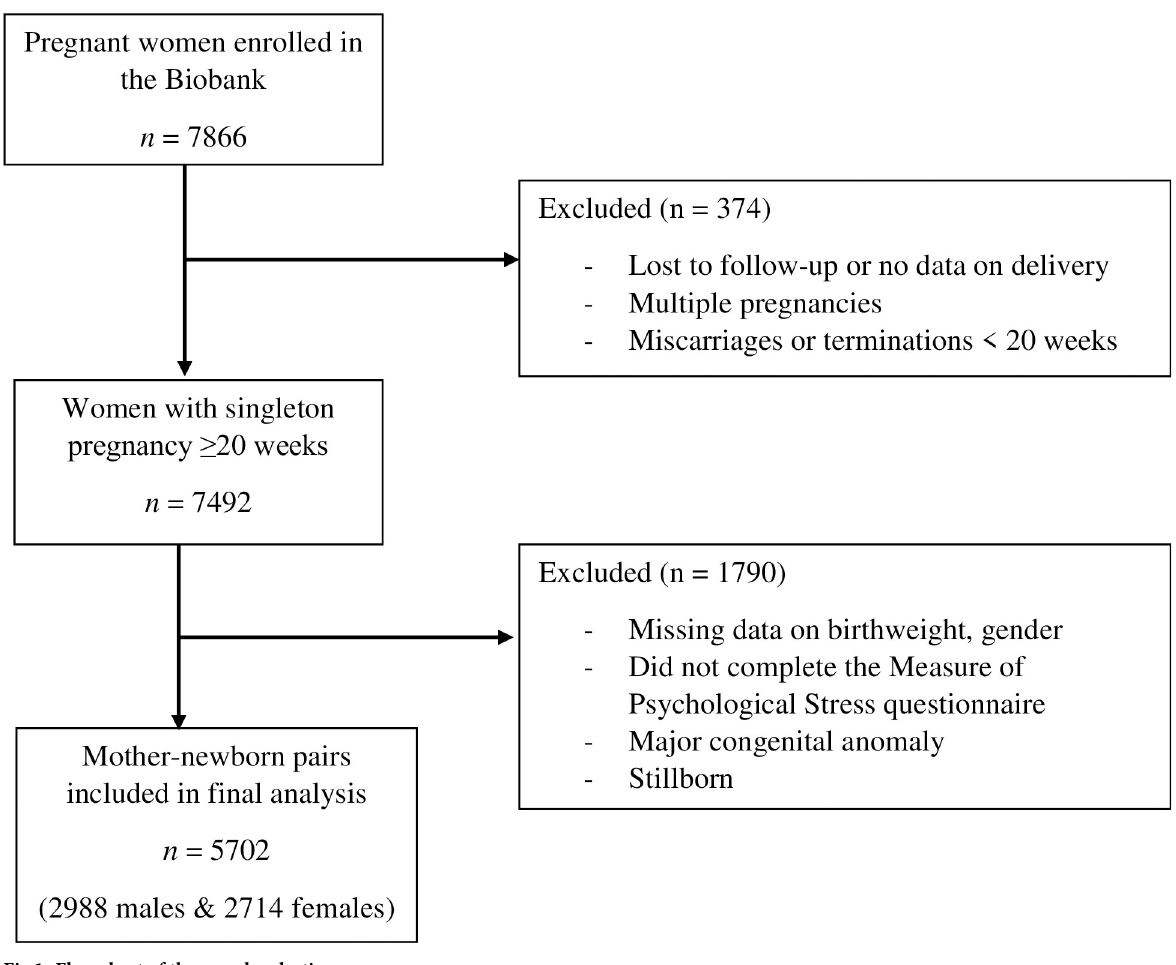
Fig 1. Flow chart of the sample selection.